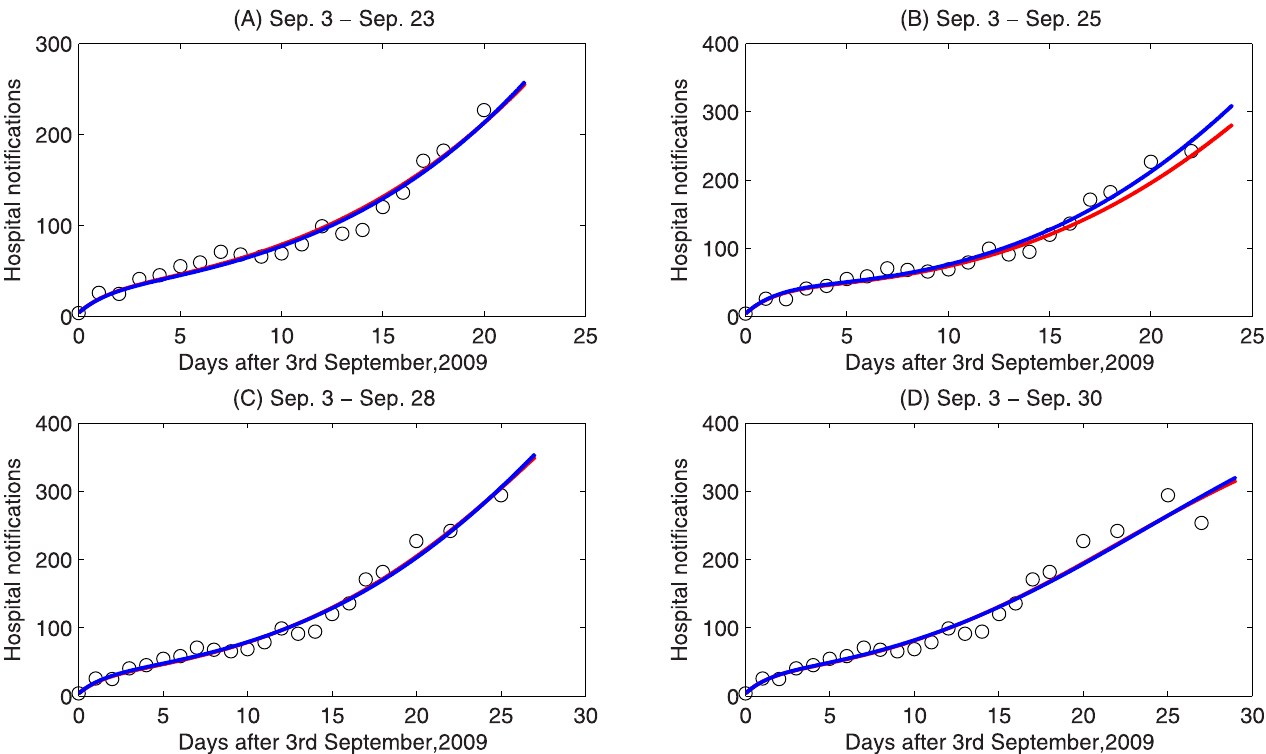
Fig 2. Data fitting for four time intervals. (A) September 3-23; (B) September3-25; (C) September 3-28; (D) September 3-30, 2009. Circles represent the hospital notifications in the 8th hospital of Xi’an, red and blue curves are the fitting curves for the model with f 1 and f 2 , respectively.